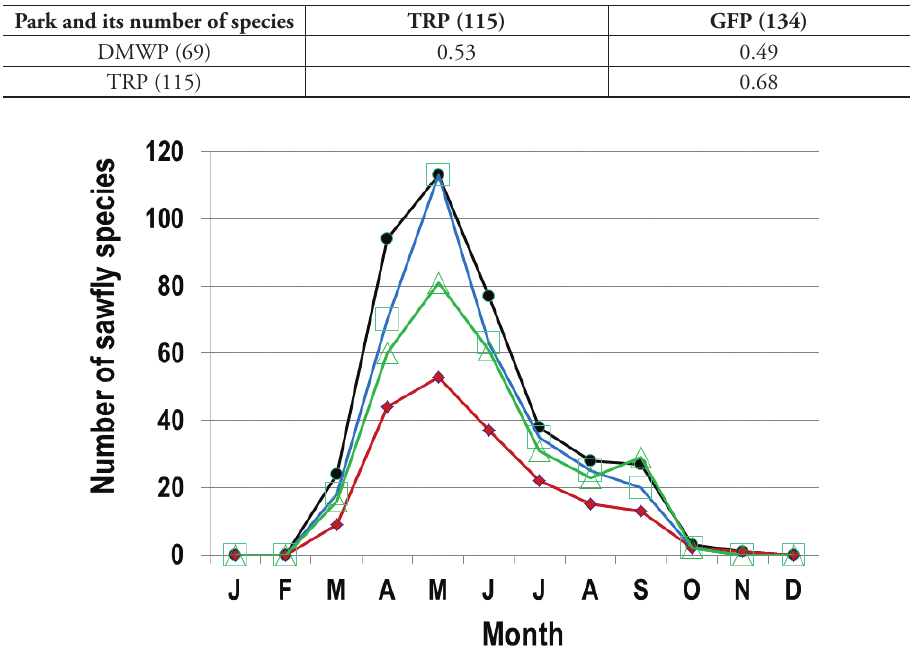
Table 2. Coefficients of community (CC) of sawflies between pairs of three parks of George Washington Park. Sawfly species numbers for each park are within parentheses.